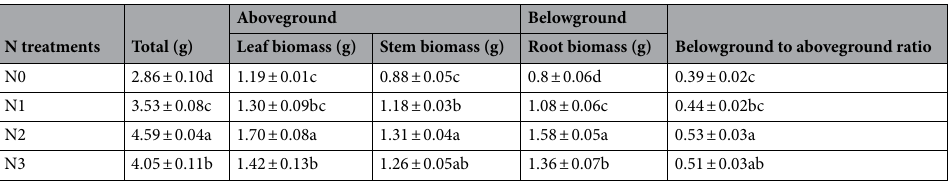
Table 1. Effects of N addition on biomass of R. soongorica. The data was mean ± SE. Different lowercase letters in each column indicate significant differences among N addition at P = 0.05.